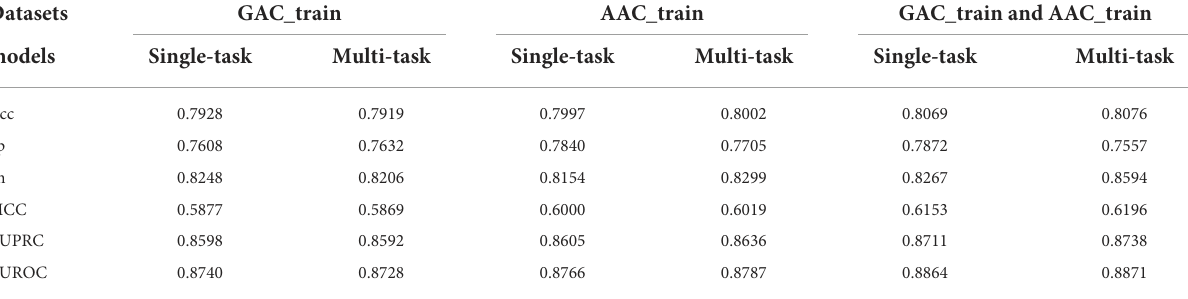
TABLE 7 Performance comparison between the single-task classification models and the classification task of the multi-task models based on GAC_train, AAC_train, and GAC_train and AAC train, respectively. Datasets GAC_train AAC_train GAC_train and AAC_train models Single-task Multi-task Single-task Multi-task Single-task